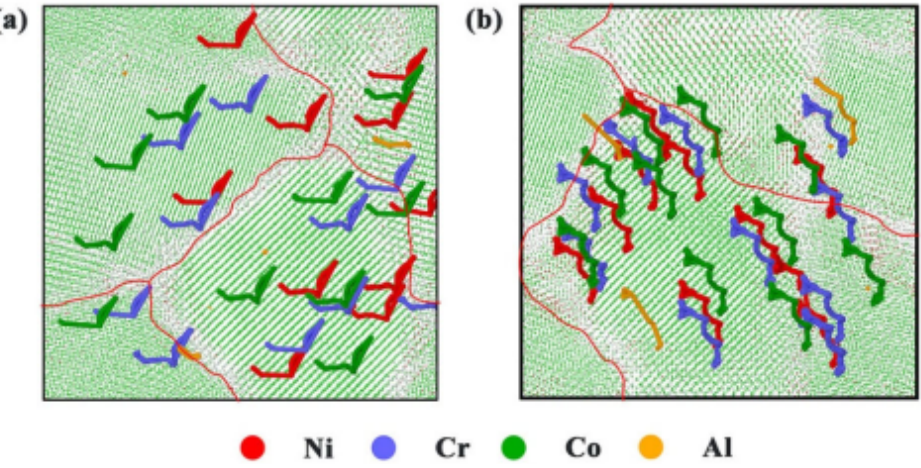
Figure 7. Atomic diffusion trajectory of medium-entropy alloy CrCoNiAl0.014 at annealing tempera- tures of 300K ( a ) and 700K ( b